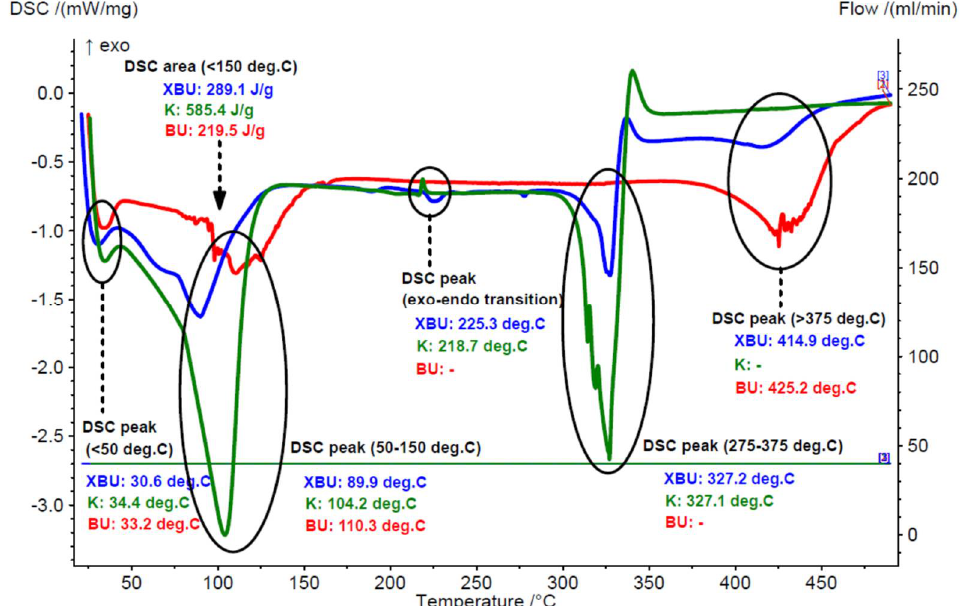
Figure 3. Superimposed DSC curves for the β-cyclodextrin/raw breast chicken lipid complex (blue), β-cyclodextrin hydrate (green), and raw breast chicken lipid fraction (red) (codes “XBU”, “K” and “BU”, duplicate samples “a”).